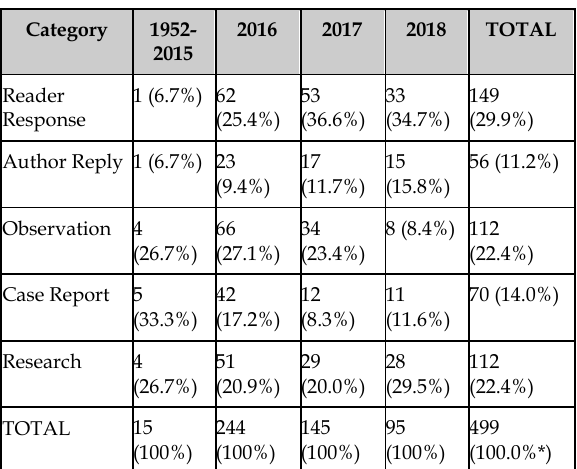
Figure 4 Letters with 0–25 References,